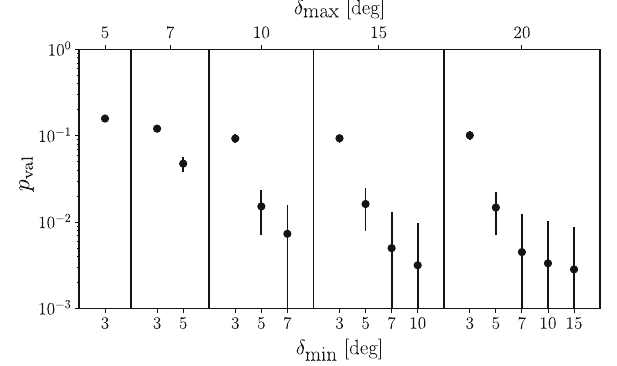
Fig. 15 Scan of the ellipse geometry ( δ max , δ min ) for the Galactic meridians initialization and λ F = 0 evaluated on the astrophysical benchmark 2 simulation with source density of ρ S = 3 × 10 − 2 Mpc − 3